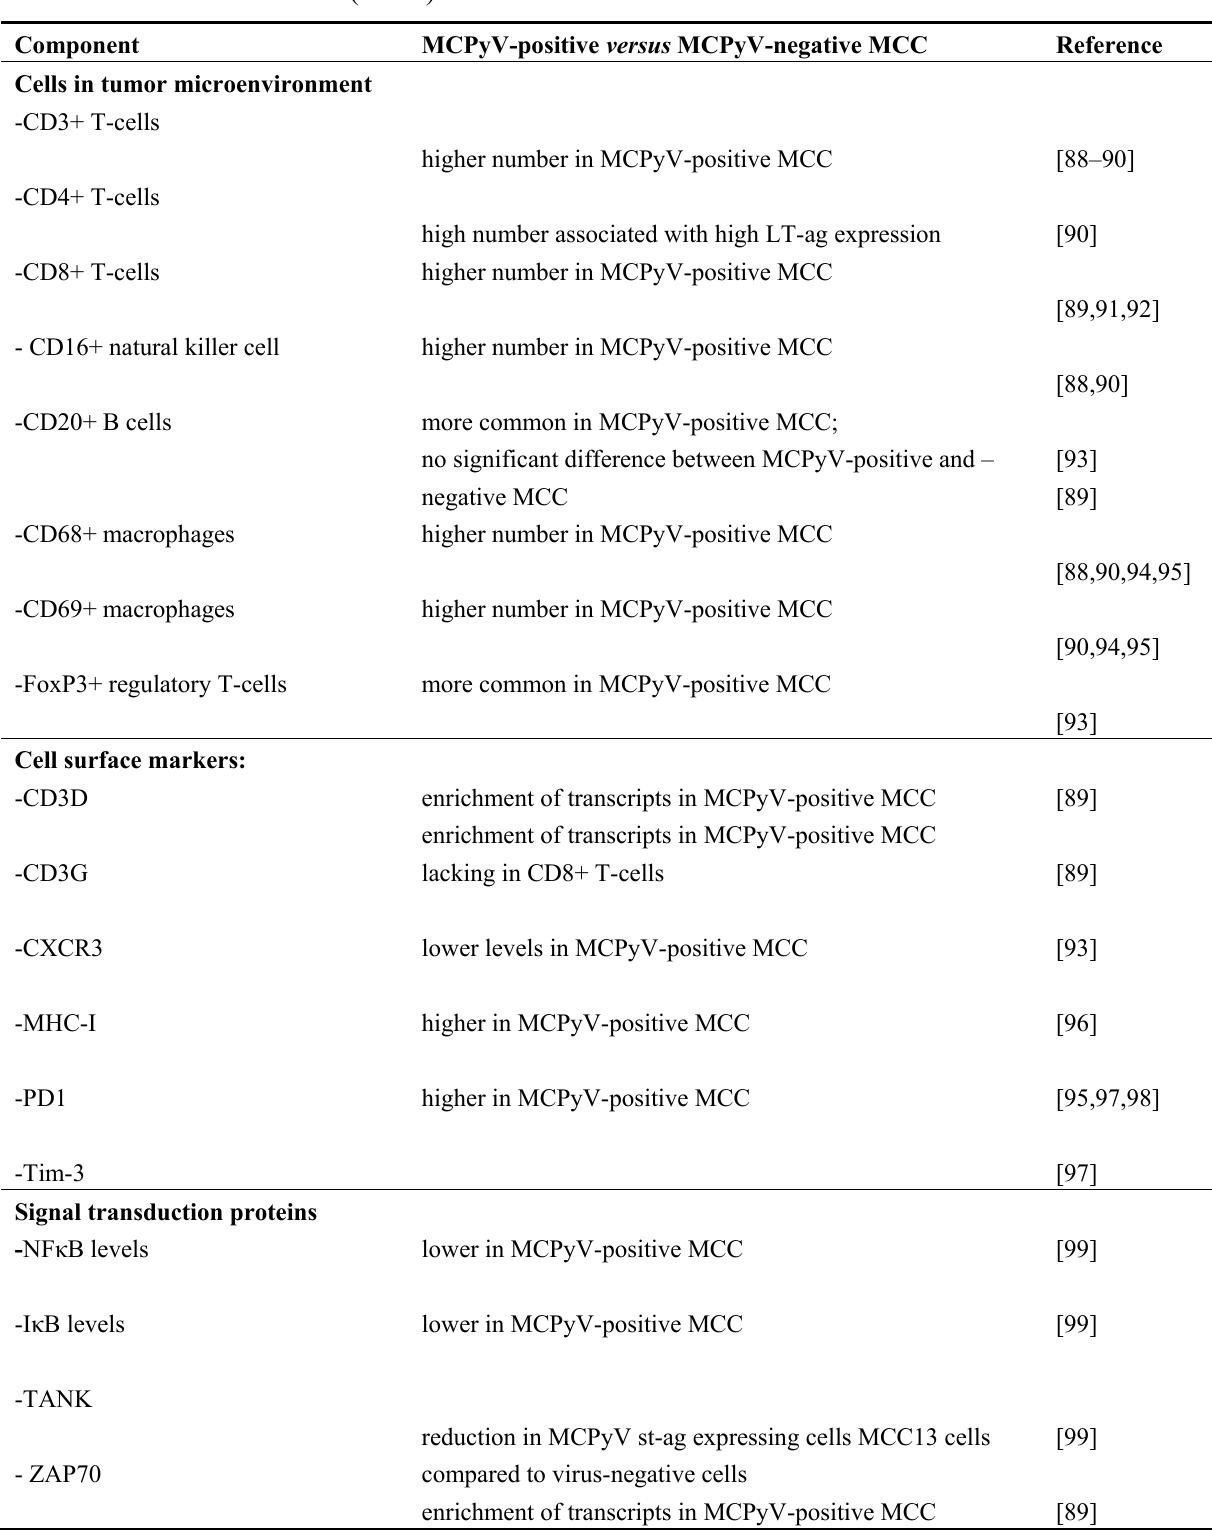
Table 2. Immune cells and inflammatory mediators in MCPyV-positive and MCPyV-negative Merkel cell carcinoma